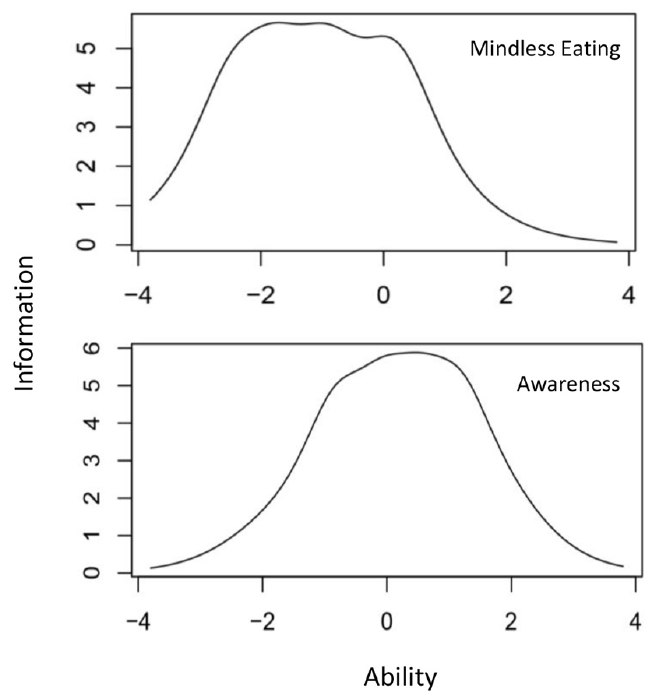
Figure 4. Test information trace lines of two subscales.